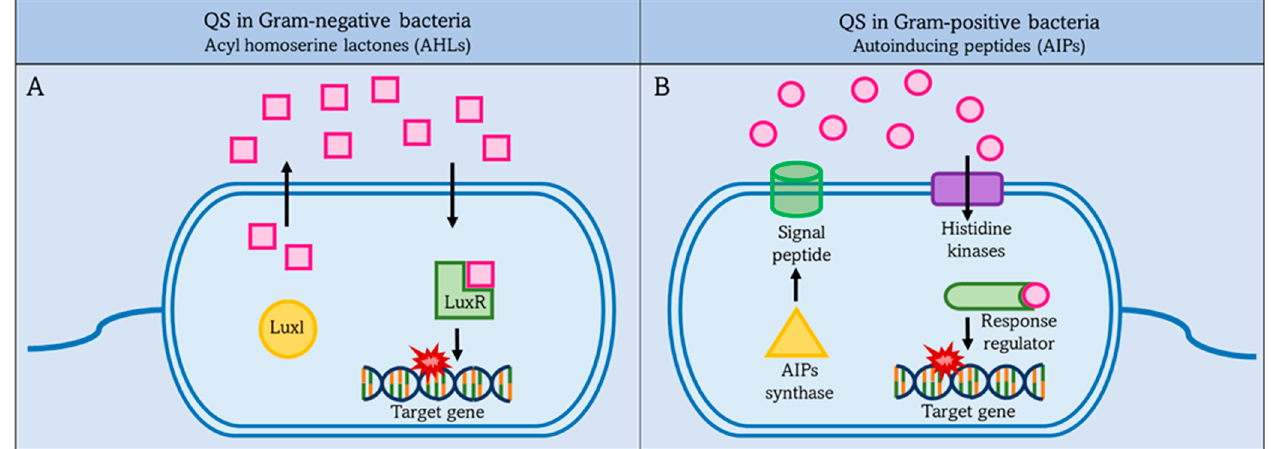
Figure 2. QS systems in Gram-negative and Gram-positive bacteria. Left figure ( A ): Gram-negative bacteria secrete acyl-homoserine lactones (AHLs) as autoinducers, which are synthesized by Luxl and then pass through the bacterial membrane into the external environment. Once the AHLs reach a threshold level, they activate intracellular LuxR to activate target gene expression. Right figure ( B ): Gram-positive bacteria secrete autoinduction peptides (AIPs), which are synthesized by AIPs synthase and then pass through the bacterial membrane into the external environment. Once the AIPs reach a threshold level. This is detected by a specific protein, histidine kinases, and activates the intracellular regulator. The response regulator leads to increased expression of the target gene.